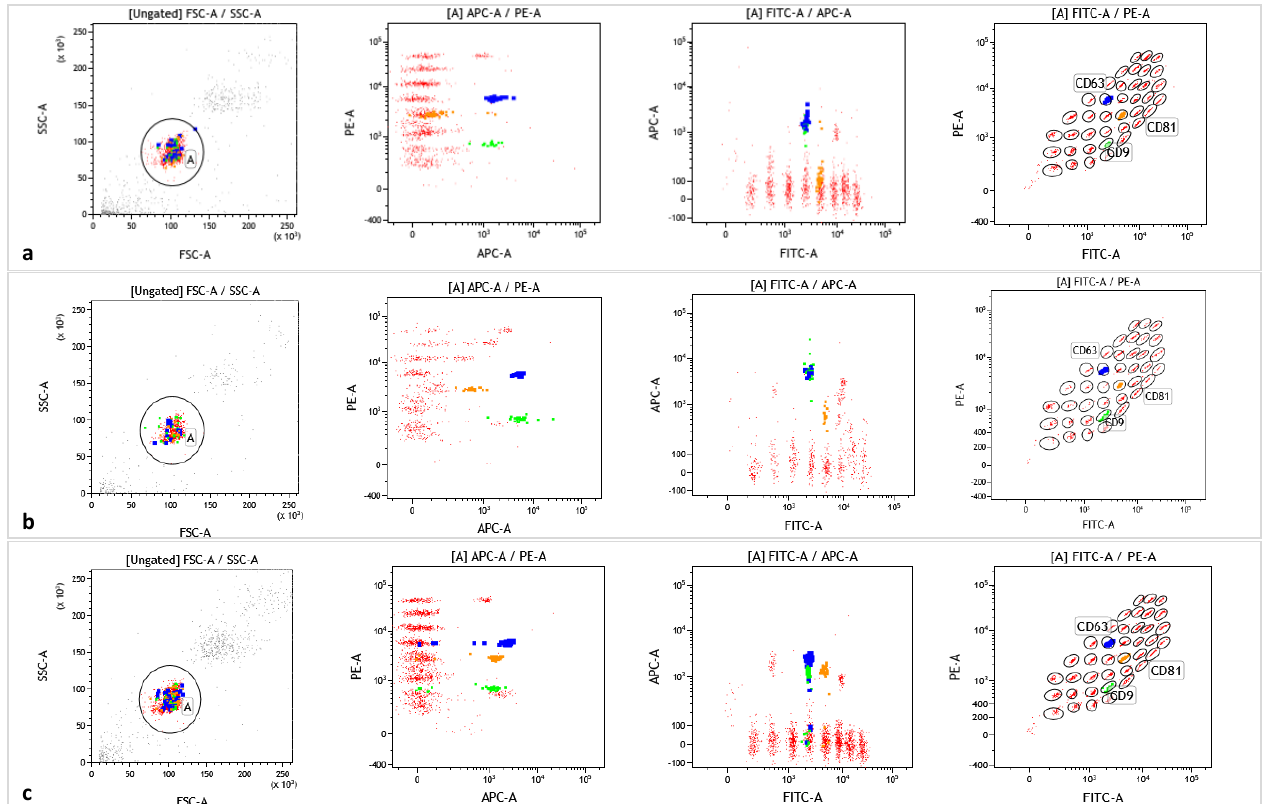
Figure 5. Gating strategy of exosome surface markers from the Siena cohort ( a ), Foggia cohort ( b ) and Barcelona cohort ( c ) analyzed using Kaluza Software 2.1 (Beckman Coulter, Cassina De’ Pecchi–Milano,